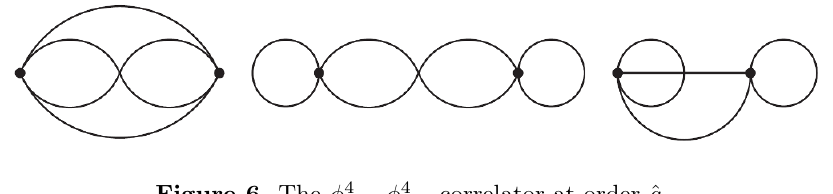
Figure 6 . The (cid:30) 4 (cid:0) (cid:30) 4 (cid:0) correlator at order ^ g